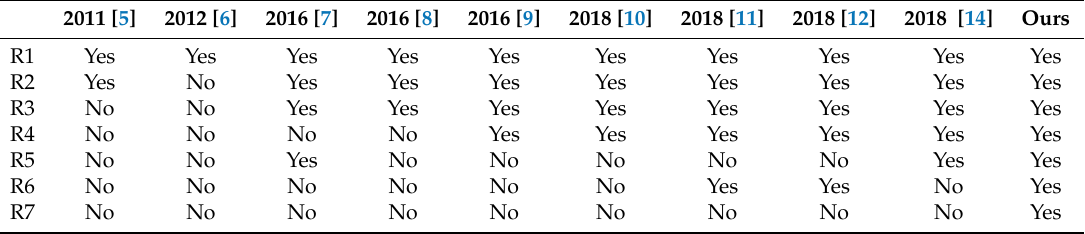
Table 2. Comparison of security features of other identity-based mutual authentication